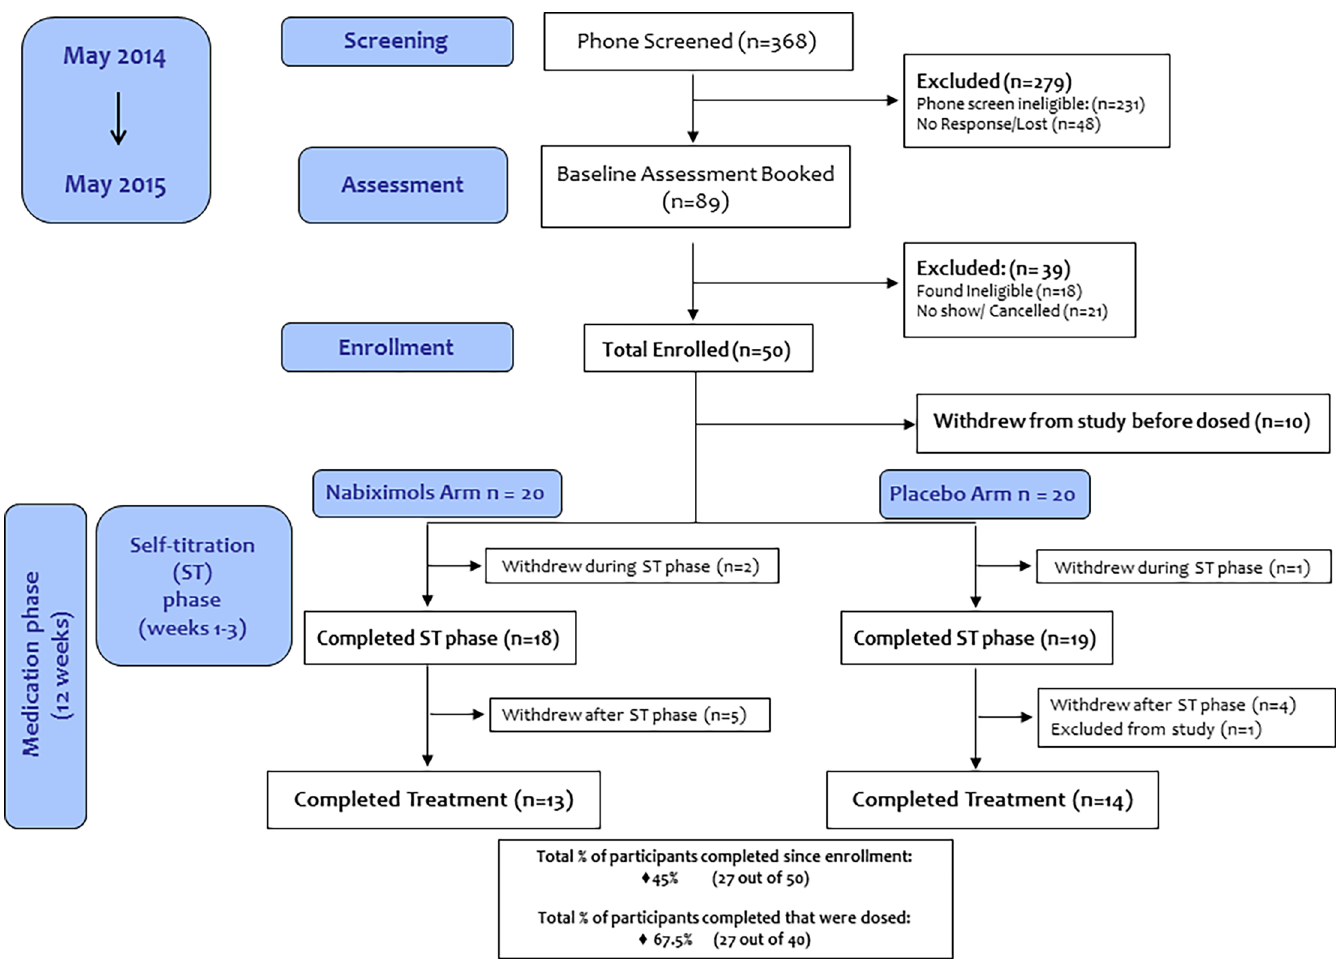
Fig 1. Consort flow diagram. Diagram shows the number of participants at each stage of the study. assigned to the nabiximols group (n = 20) reported using cannabis an average of 6.7 days /week (SD = 0.8) at baseline, consuming 6.2 g/week (SD = 5.0). Participants in the placebo group (n = 20) reported using cannabis 6 days /week at baseline (SD = 1.8), consuming an average of 5.9 g /week (SD = 5.0).